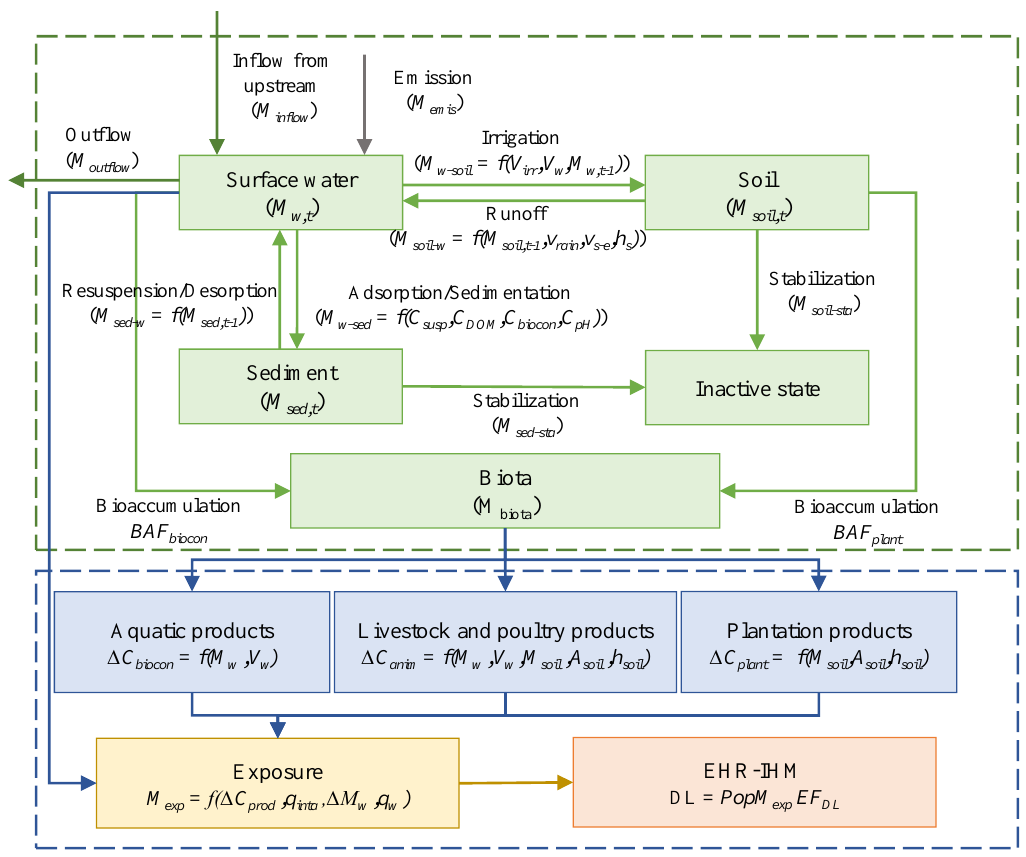
Figure 1. The framework of the EHR-IHM assessment method.